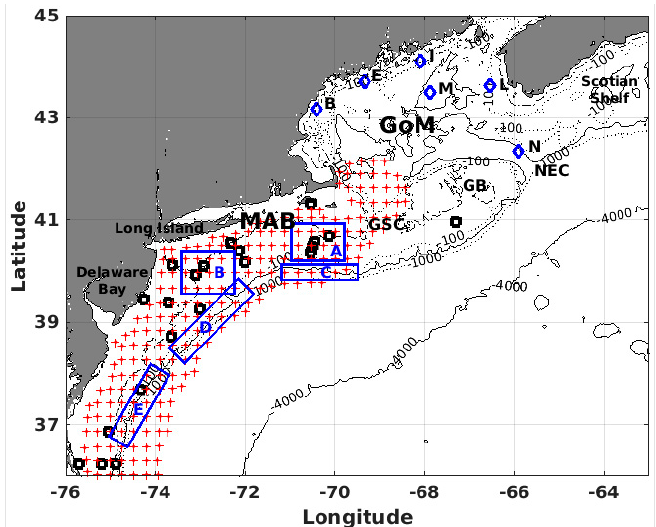
Figure 1. Map of study region showing a set of in situ current measurement locations. Northeast Regional Association of Coastal Ocean Observing Systems (NERACOOS) moored Acoustic Doppler Current Profilers (ADCP) current buoys are in GoM (blue diamonds). In MAB the sites (black circles) of the in situ depth-average mean current dataset by Lentz [26] are shown as well as coastal ocean dynamics applications radar (CODAR) high frequency (HF) Radar current observations (red pluses) from Mid-Atlantic Regional Coastal Ocean Observing System (MARACOOS). Key geographic locations are noted, including the Scotian Shelf, Gulf of Maine (GoM), Northeast channel (NEC), Georges Bank (GB), Great South Channel (GSC), and Mid Atlantic Bight (MAB). Five selected analysis focus areas (blue boxes) in the MAB are labeled (A–E). Contours are for the 50-, 100- 1000-, and 4000-m isobaths.